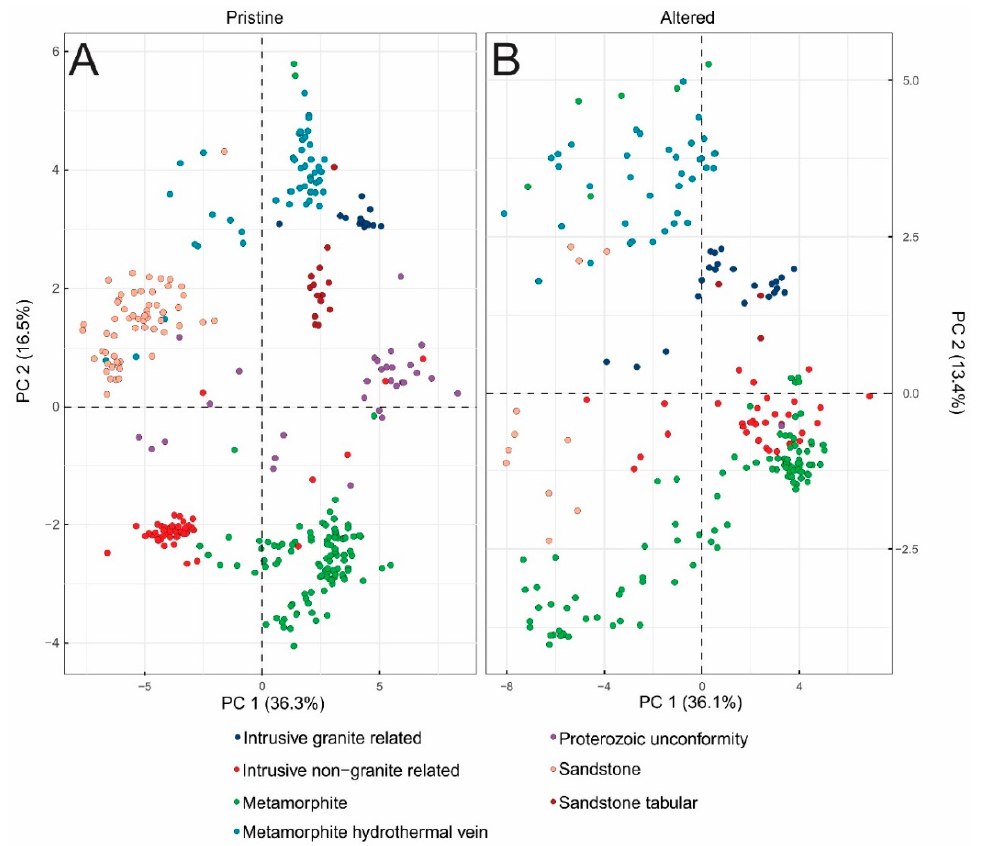
Figure 10. Principal component analysis for ( A ) pristine and ( B ) altered uraninite samples using major elements (wt. %; Table S1), REE abundances (ppm; Table S2) and the Sr, Pb, and U isotopic